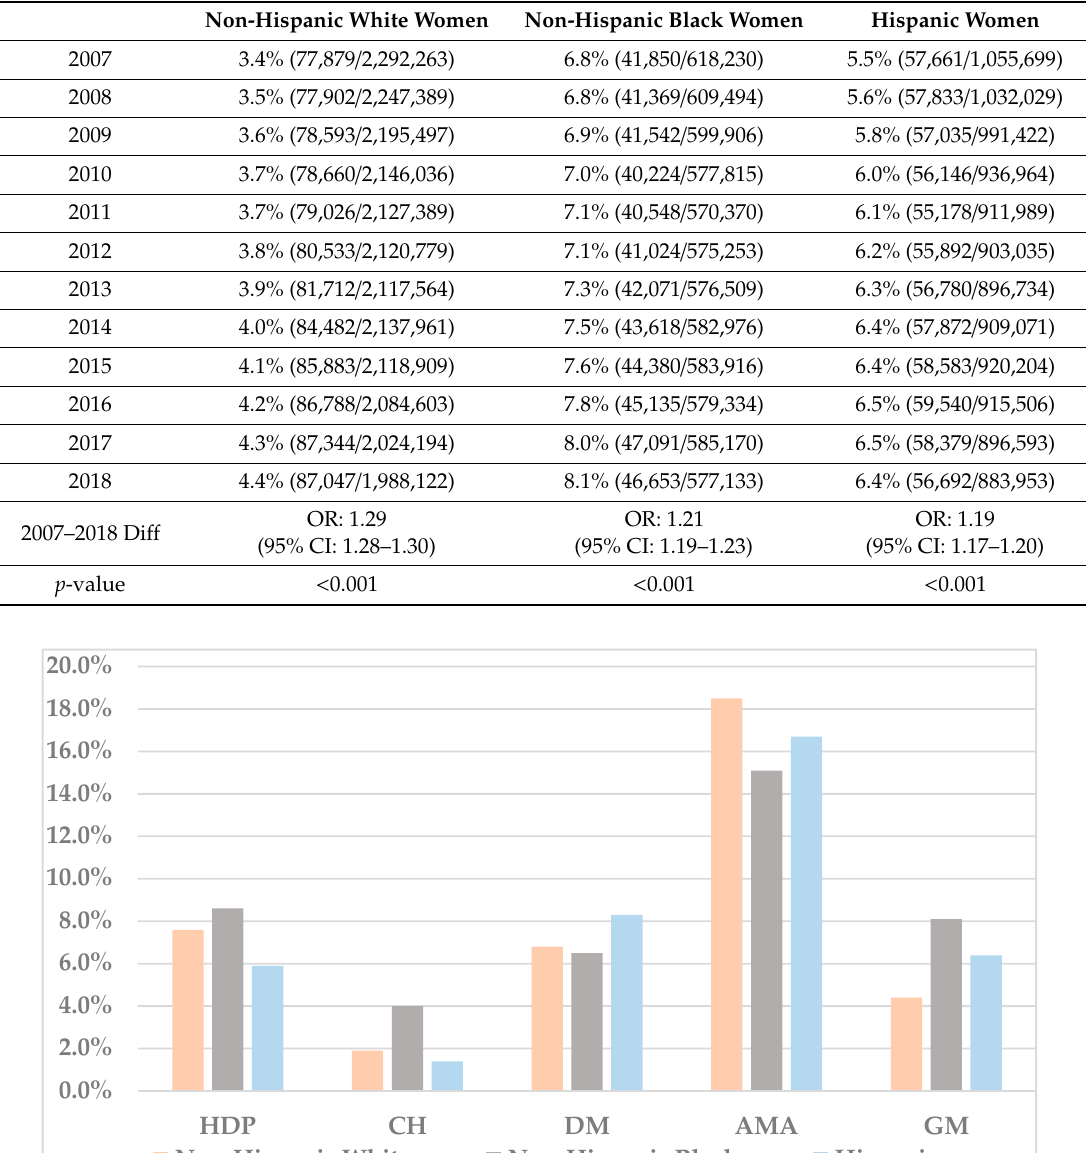
Table 5. Annual prevalence of grand multiparity (GM) for 2007–2018, by racial/ethnic group.